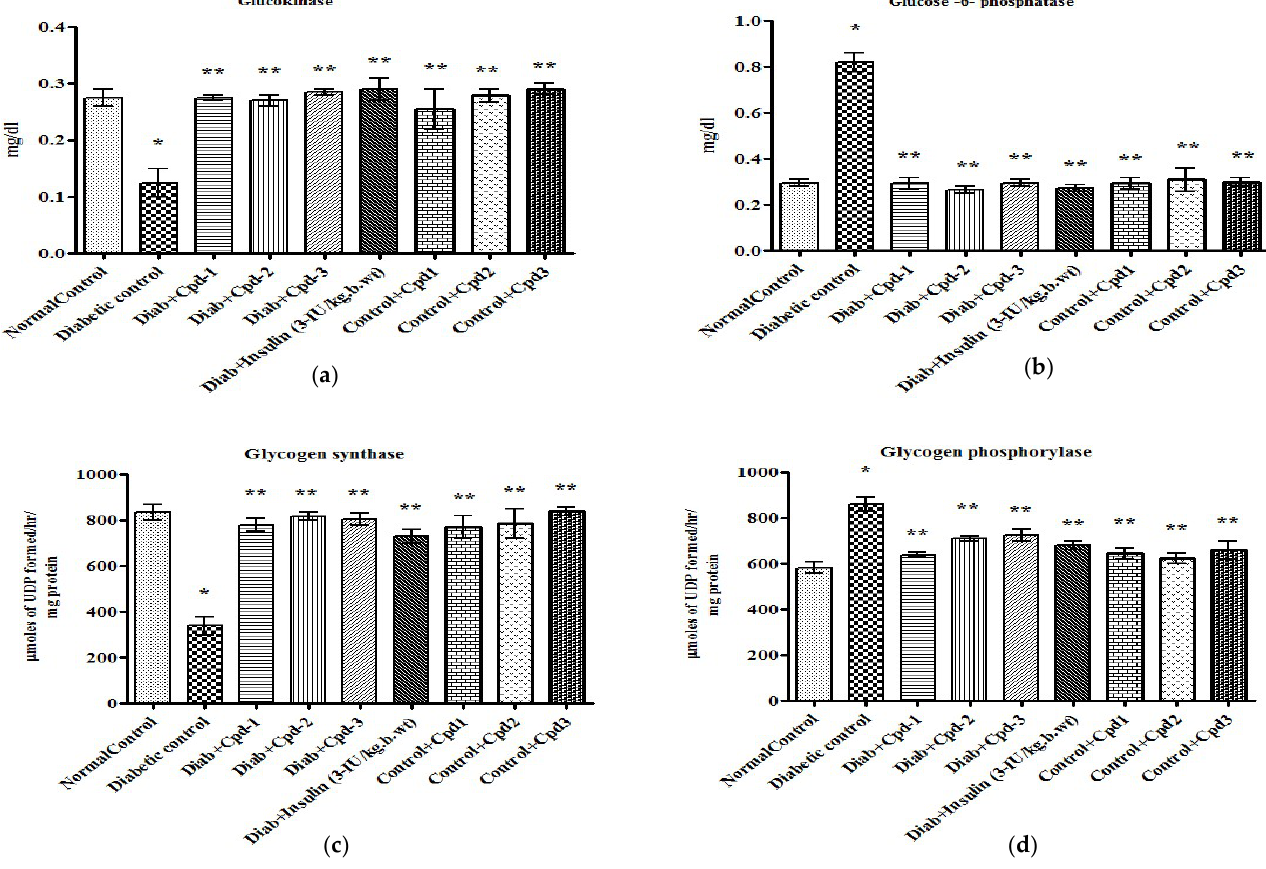
Figure 4. Effect of novel triterpenoids on ( a ) glucokinase; ( b ) glucose 6-phosphatase; ( c ) glycogen synthase; ( d ) glycogen phosphorylase in STZ-induced diabetic rats compared with the effect of insulin. Each bar represents mean ± SEM of 6 animals. Significance at p < 0.05; *, compared with control; **, compared with diabetic control.